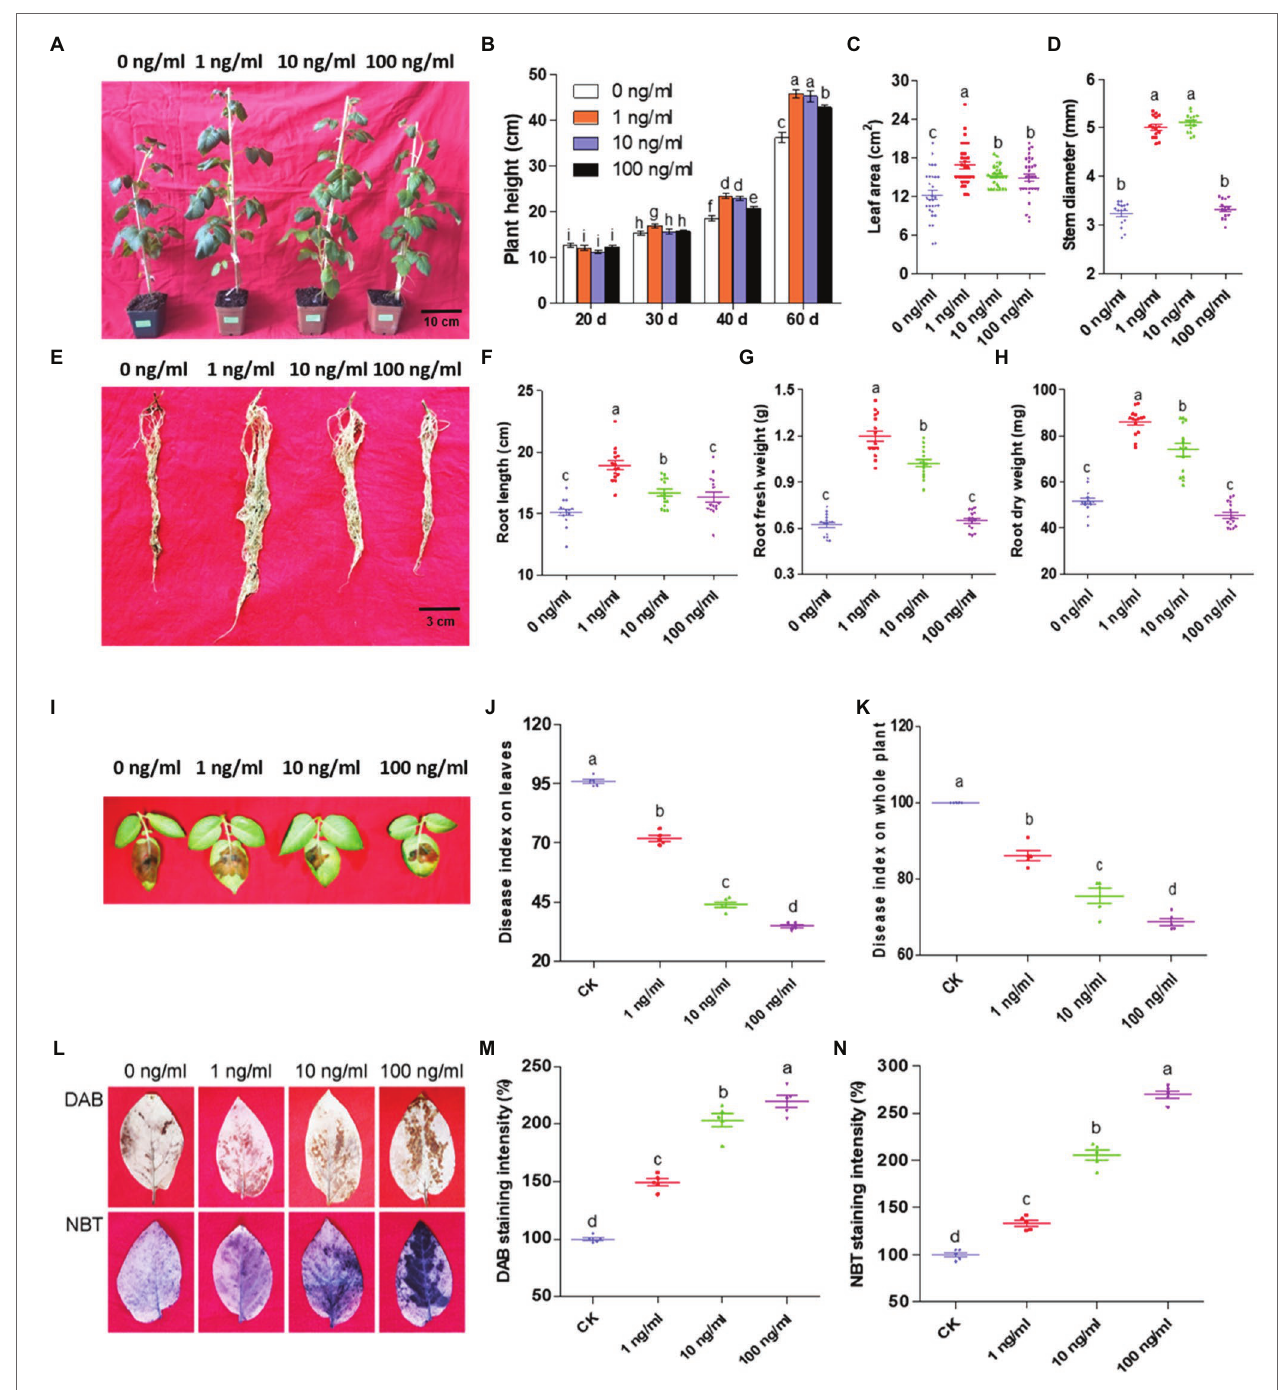
FIGURE 1 | Zhinengcong (ZNC) promotes potato growth and late blight resistance corresponds with ROS accumulation. (A) Potatoes at day 60 after cultivation. Scale bars = 10 cm. (B) Statistical analysis of the aerial part at day 20, 30, 40, and 60. Scale bars = 3 cm. Data are shown as the mean (15) ± SD. (C) Potato leaf area at day 60. Data are shown as the mean (30) ± SD. (D) Stem diameter at day 60. Data are shown as the mean (15) ± SD. (E) Roots at day 80. Scale bars = 3 cm. (F–H) Root length, fresh root weight, and dry root weight at day 80. Data are shown as the mean (15) ± SD. (I) Potato leaves inoculated with Phytophthora infestans and treated with ZNC at day 40. (J) The disease index of detached leaves analyzed on the 5th day after inoculation. Data are shown as the mean (5) ± SD. (K) The disease index of whole plants analyzed on the 7th day after inoculation. Data are shown as the mean (5) ± SD. (L) Hydrogen peroxide (upper panel) and superoxide accumulation (lower panel) in potato leaves treated with 0, 1, 10, and 100 ng/ml ZNC at 2 h post treatment (hpt). (M,N) Quantification of ROS staining intensity by DAB (M) and NBT (N) in potato leaves treated with 0, 1, 10, and 100 ng/ml ZNC at 2 h post treatment (hpt). Data are shown as the mean (5) ± SD. In the